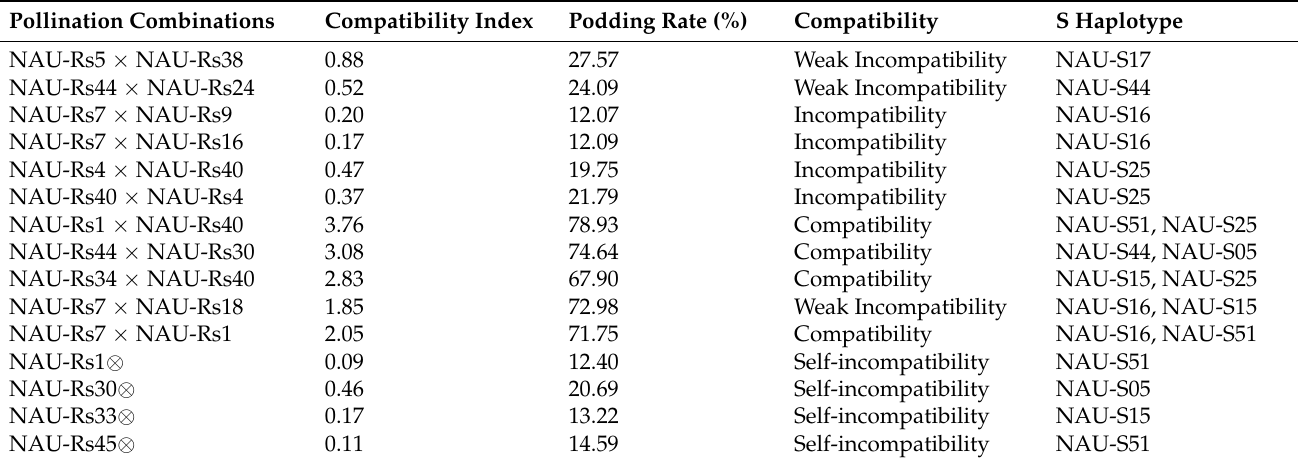
Table 6. Compatibility index and podding rate of different pollination